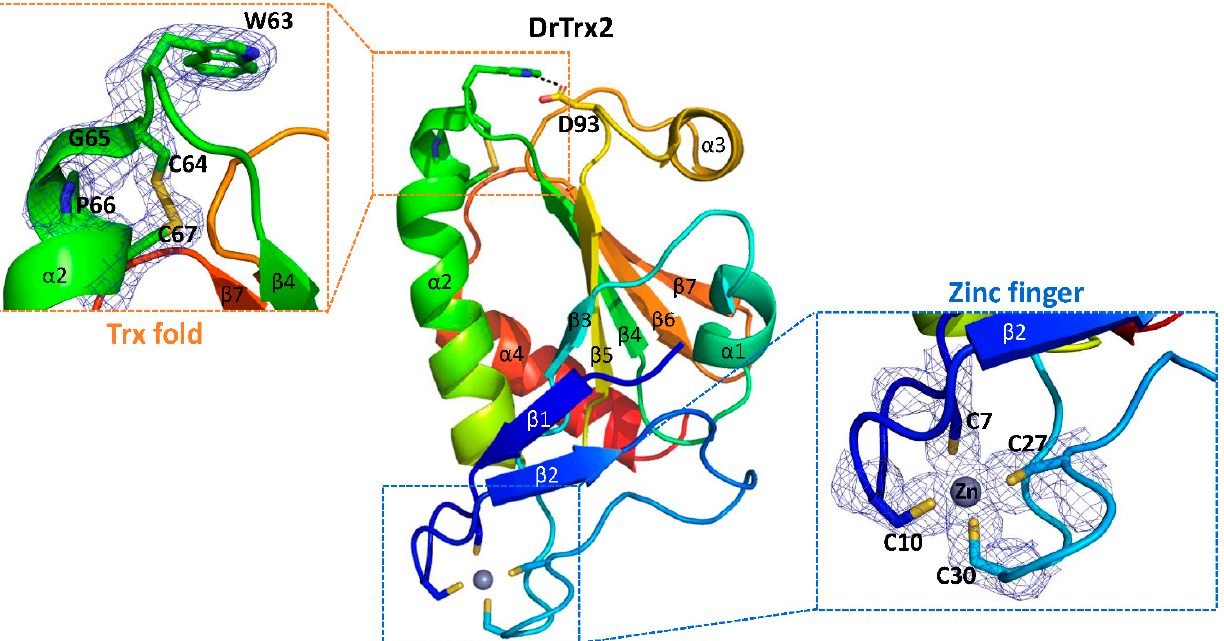
Figure 5. Conserved cysteine residues in DrTrx2. A cartoon representation of the full-length structure of DrTrx2 is provided in a different orientation compared to Figure 4. The molecule is colored progressively, from blue at the N-terminus to red at the C-terminus. The amino acid residues in the active site 63 WCGPC 67 motif, the N-terminal zinc binding site, and Asp93, which makes a hydrogen bond (dotted black line) with Trp63, are shown as sticks. Dotted rectangles indicate enlarged views of the active site 63 WCGPC 67 motif (orange) and the N-terminal zinc binding site (blue). The zinc ion is shown as a gray sphere. The final maximum-likelihood weighted 2 F o - F c electron density map of 63 WCGPC 67 and four cysteine residues coordinated with zinc ion contoured at 1 σ are also presented as mesh.